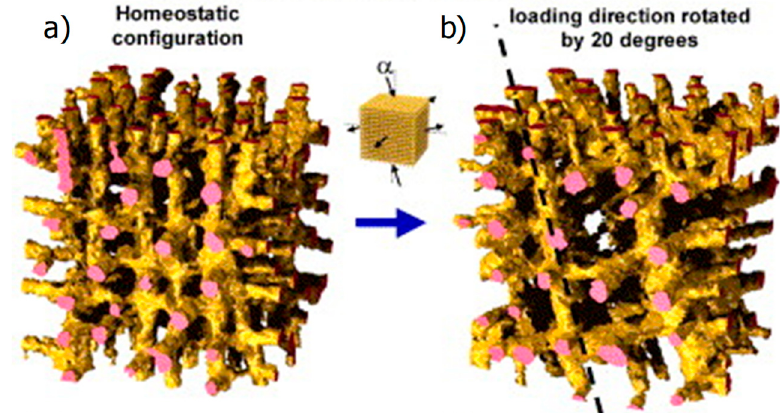
Figure 3. ( a ) The negative feedback loop used as a control function resulted in a homeostatic configuration of the trabecular bone orientation. ( b ) Changing the loading direction to be 20 degrees away from the vertical direction leads to a reorientation of the trabecular architecture (from [45] with permission).